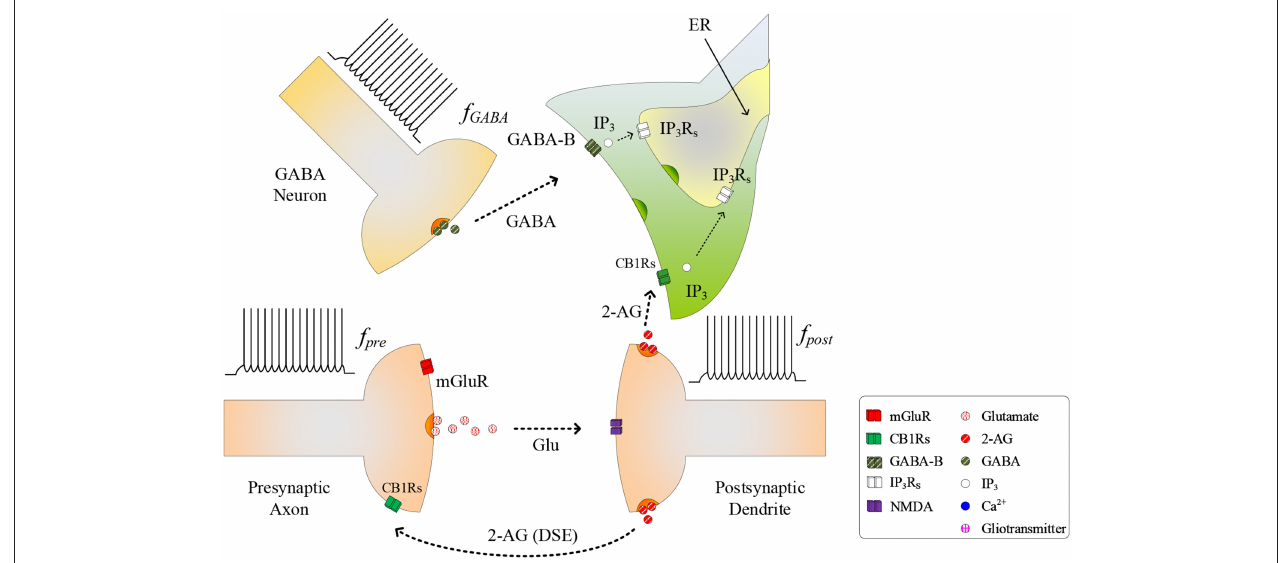
FIGURE 2 | Signaling pathways of the tripartite synapse where for high f post T CICR is reached and hence the Ca 2 + oscillation and the Glu (e-SP) pathway ceases causing PR to fall and the plasticity window shuts: PR also falls due to the increase in the 2-AG (DSE) pathway. Under this condition the level of neurotransmitter in the cleft falls to baseline and f post